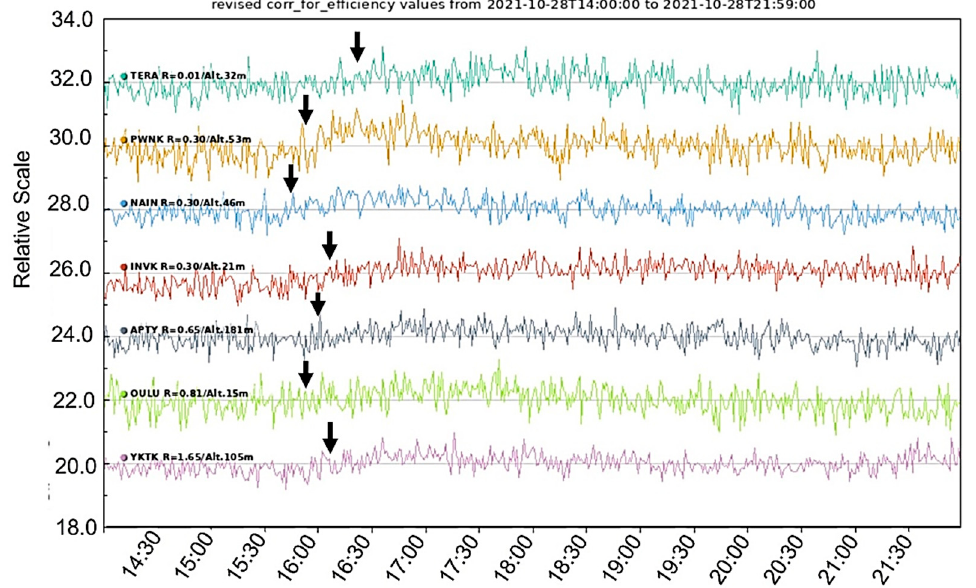
Figure 8. NM stations that detected GLE73 with small amplitude and did not give alert signal in the A.Ne.Mo.S. GLE Alert Systems.